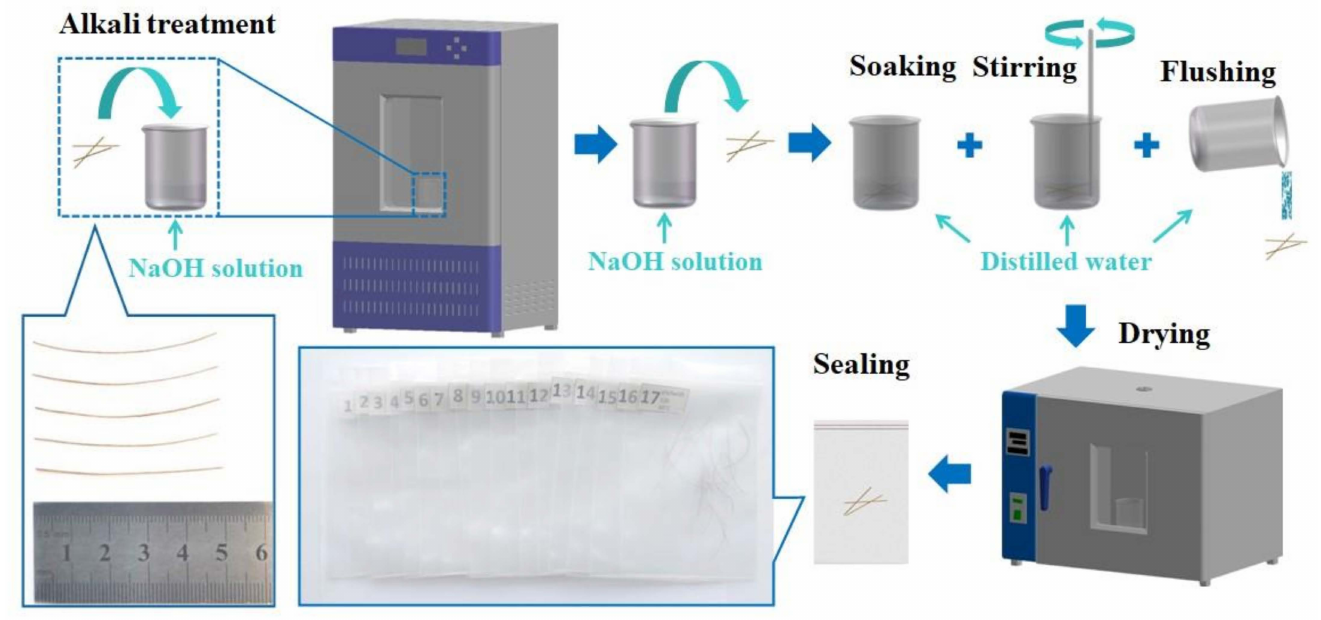
Figure 2. Preparation process of coir fiber samples.